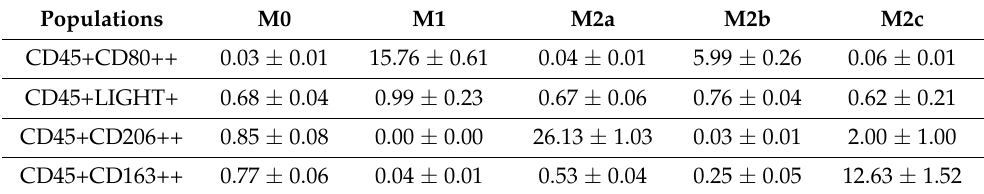
Table 1. Population frequencies of human uncommitted, M1, M2a, M2b, and M2c.